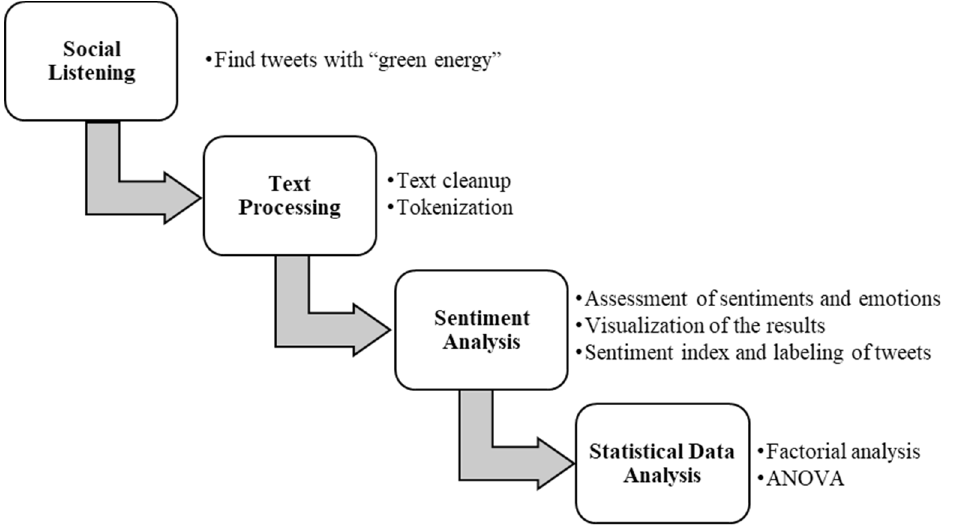
Figure 1. Methodology. Figure 1.